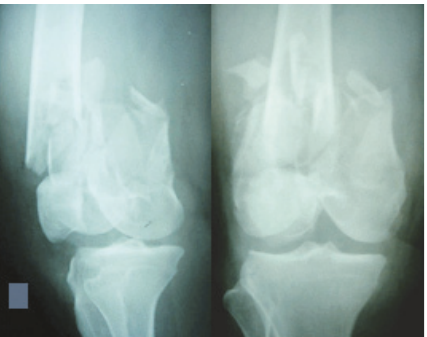
Figure 1: Bone defect after